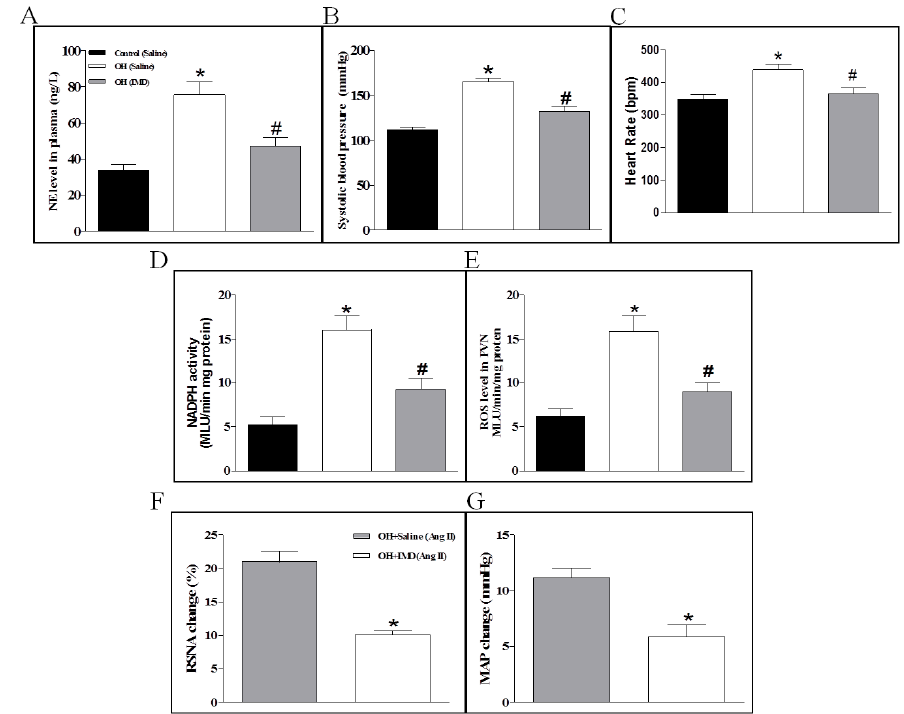
Figure 7. The e ffects of chronic application of IMD (50 pM, 0.11 µL/hr) in the PVN for 28 days on the plasma NE level ( A ), systolic blood pressure ( B ), PVN NADPH oxidase activity and ROS content in control and OH rats ( C , D ); and RSNA and MAP responses to Ang II (0.3 nM) in the PVN of OH rats ( E , F ). Values are mean ± SEM. * p < 0.05 versus control (saline); # p < 0.05 versus OH (saline) ( A – D ). * p < 0.05 versus OH (saline) ( E , F ). n = 6 or 7 for each group.